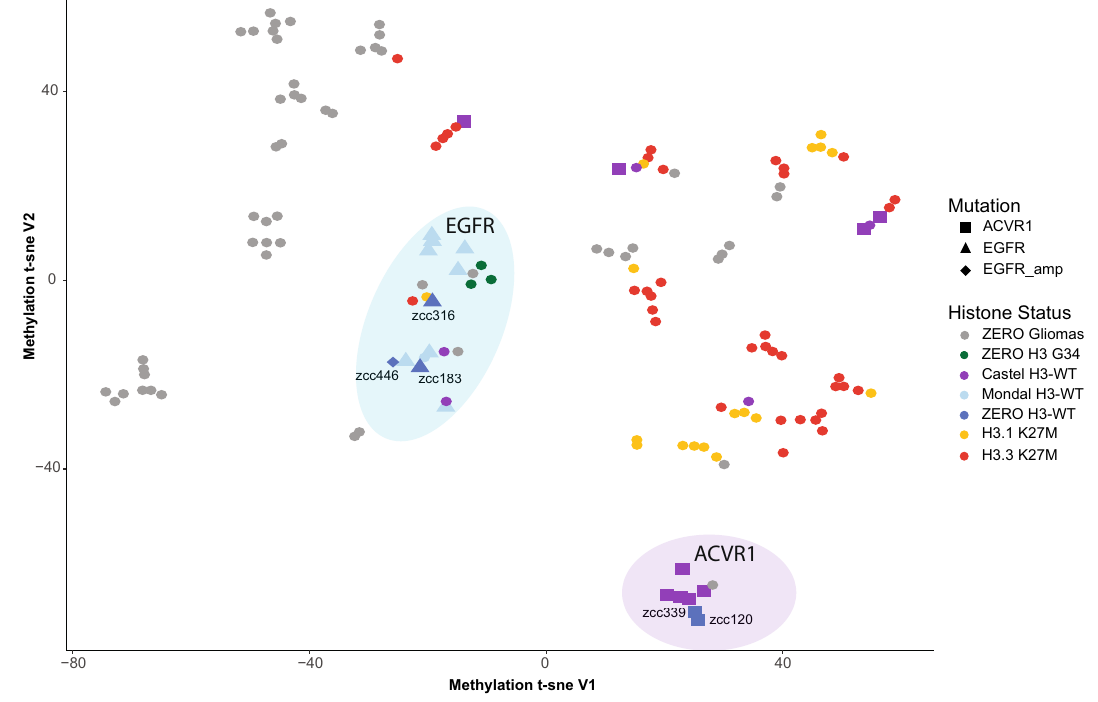
Figure 2. Methylation profiles show segregation between mutant ACVR1 and mutant EGFR H3-WT. t-SNE unsupervised clustering of the methylation profiles of the ZERO gliomas (N = 53; grey), ZERO H3 G34 mutants (N = 3; green), Castel (N = 14), Mondal (N = 9) and ZERO H3-WT (N = 5) midline glioma cohorts (purple, light blue and blue, respectively), and H3.1 K27M (N = 17) and H3.3 K27M (N = 37) (yellow and red, respectively) from all three